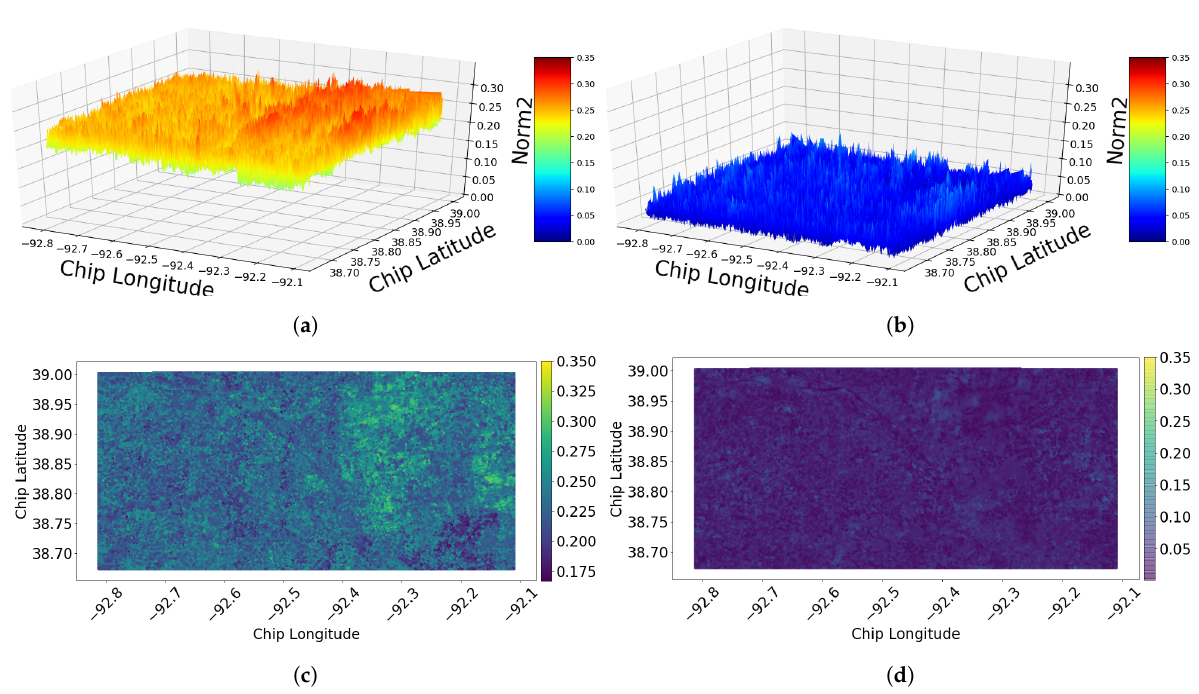
Figure 8. Norm2 of the change based on the chip-level utilizing neighborhood method of (1-N) during two different time periods: ( a ) 3D (2011–2015). ( b ) 3D (2015–2017). ( c ) 2D (2011–2015). ( d ) 2D